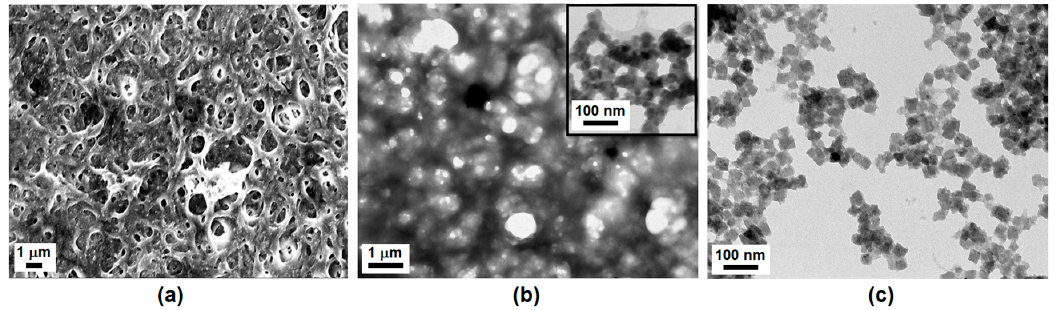
Figure 2. Morphological study of the chitosan/PB nanocomposite (ChPBN) film as prepared for the SS-Na+ISE and the control set Prussian blue (PB) nanoparticles: ( a ) SEM image of the ChPBN thin film; ( b ) TEM images of ChPBN thin film at low (main) and high (inset) magnifications; ( c ) TEM images of PB nanoparticles without the chitosan matrix.